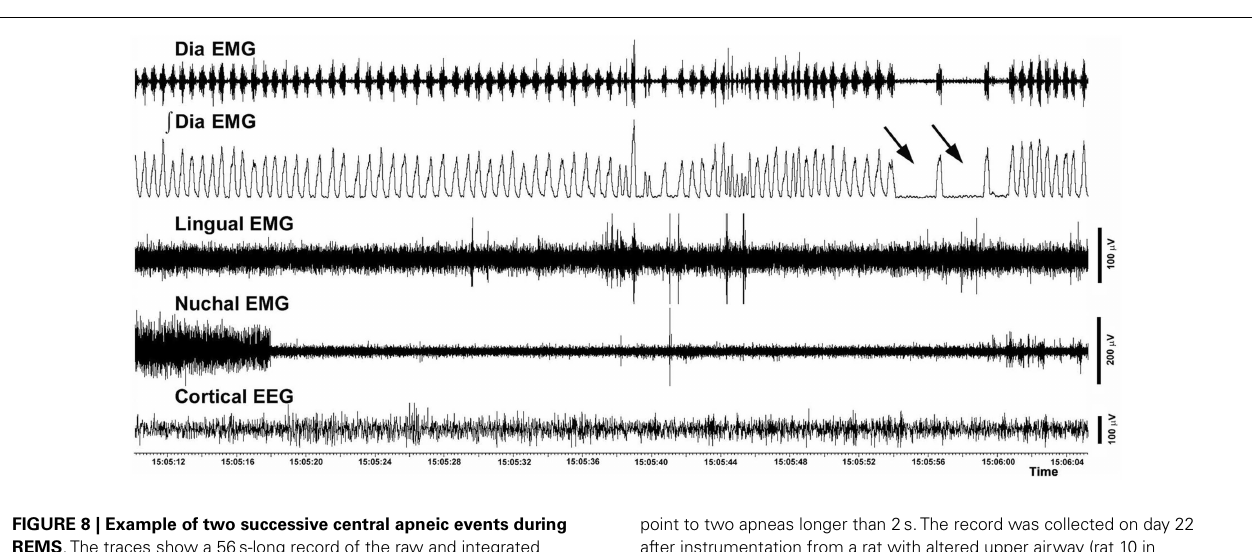
FIGURE 8 | Example of two successive central apneic events during REMS .The traces show a 56s-long record of the raw and integrated diaphragmatic EMG, raw lingual and nuchal EMGs and EEG. Arrows